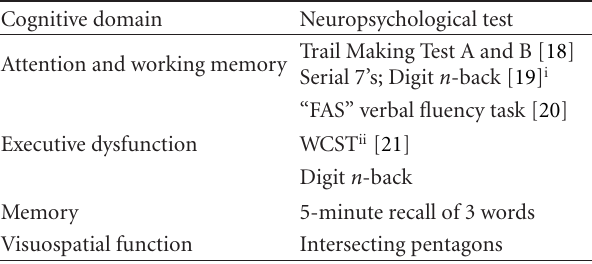
Table 1: Pragmatic neuropsychological test battery and cognitive domains administered to the PD participants without